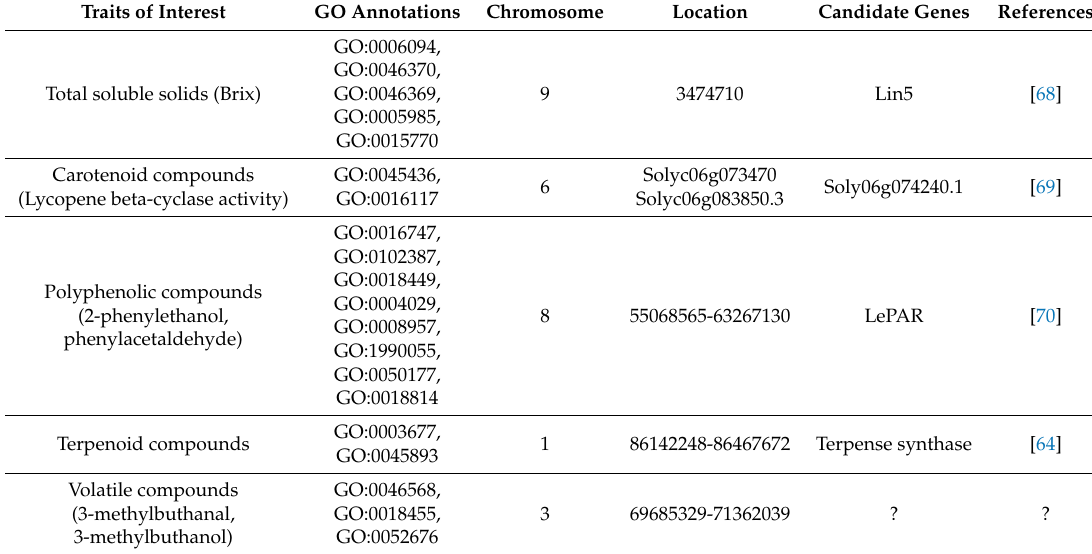
Table 2. A selected set of five QTLs for metabolic traits in tomatoes. These QTLs are used as test cases to analyse the prediction power of the underlying